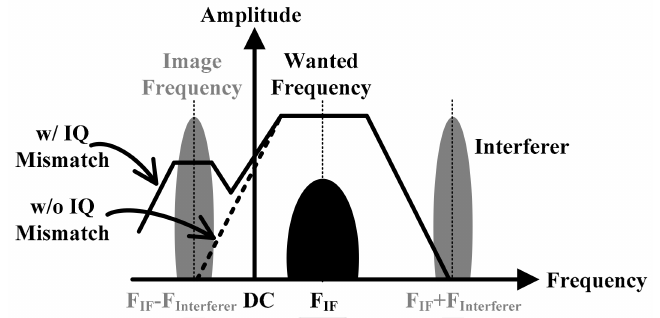
Figure 1. AC characteristics of low-IF receiver when I/Q mismatch occurs.